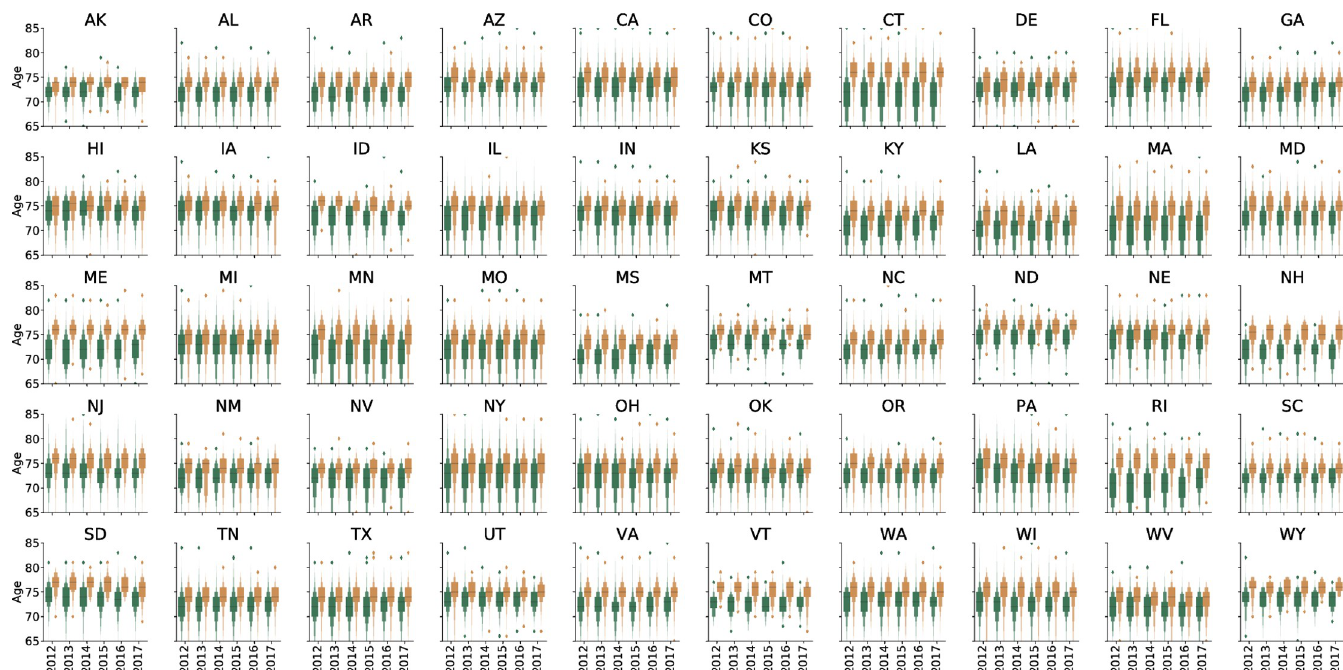
Fig 1. Letter-value plot for average age of Medicare beneficiary population by state and eye provider type. Ophthalmologists are shown in yellow and optometrists are shown in green. The black line represents the median value.